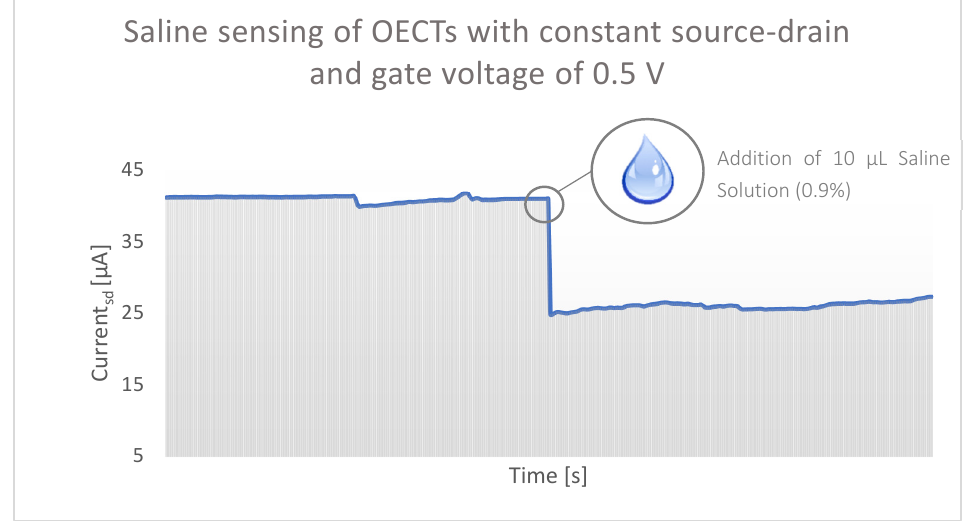
Figure 12. Change in current output under the addition of saline solution over time.